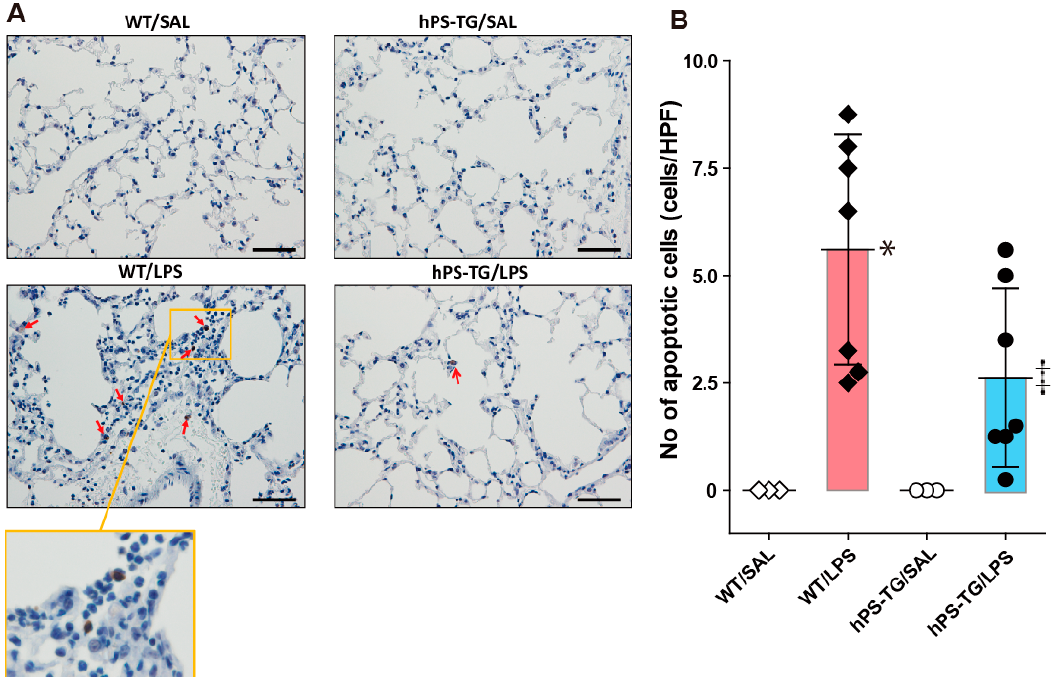
Figure 5. Decreased lung apoptotic cells in mice overexpressing hPS. Mice were allocated in four groups including wild type mice treated with saline (WT/SAL, n = 3) or LPS (WT/LPS, n = 7), and human PS transgenic (TG) mice treated with saline (hPS TG/SAL, n = 3) or LPS (hPS TG/LPS, n = 7). Staining of terminal deoxynucleotidyl transferase dUTP nick-end labeling (TUNEL) was performed as described under materials and methods ( A ) and the number of apoptotic cells was counted using WindROOF image processing software ( B ). Arrows indicate apoptotic cells. Scale bars indicate 100 µ m. Data are expressed as the mean ± SD. * p < 0.05: WT/LPS vs WT/SAL; ‡ p < 0.05: hPS-TG/LPS vs WT/LPS.